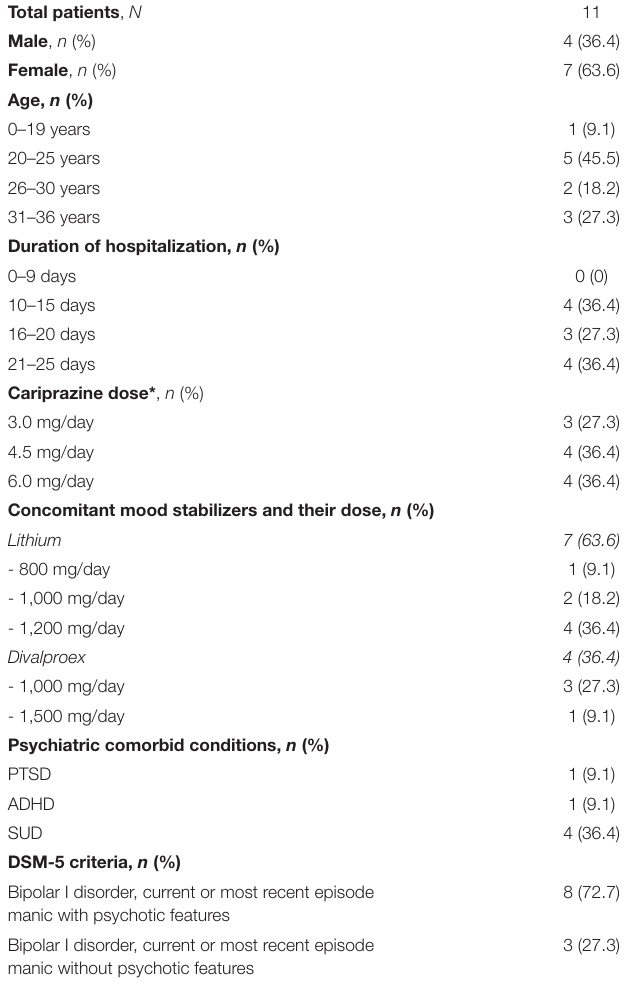
TABLE 1 | Summary of patient